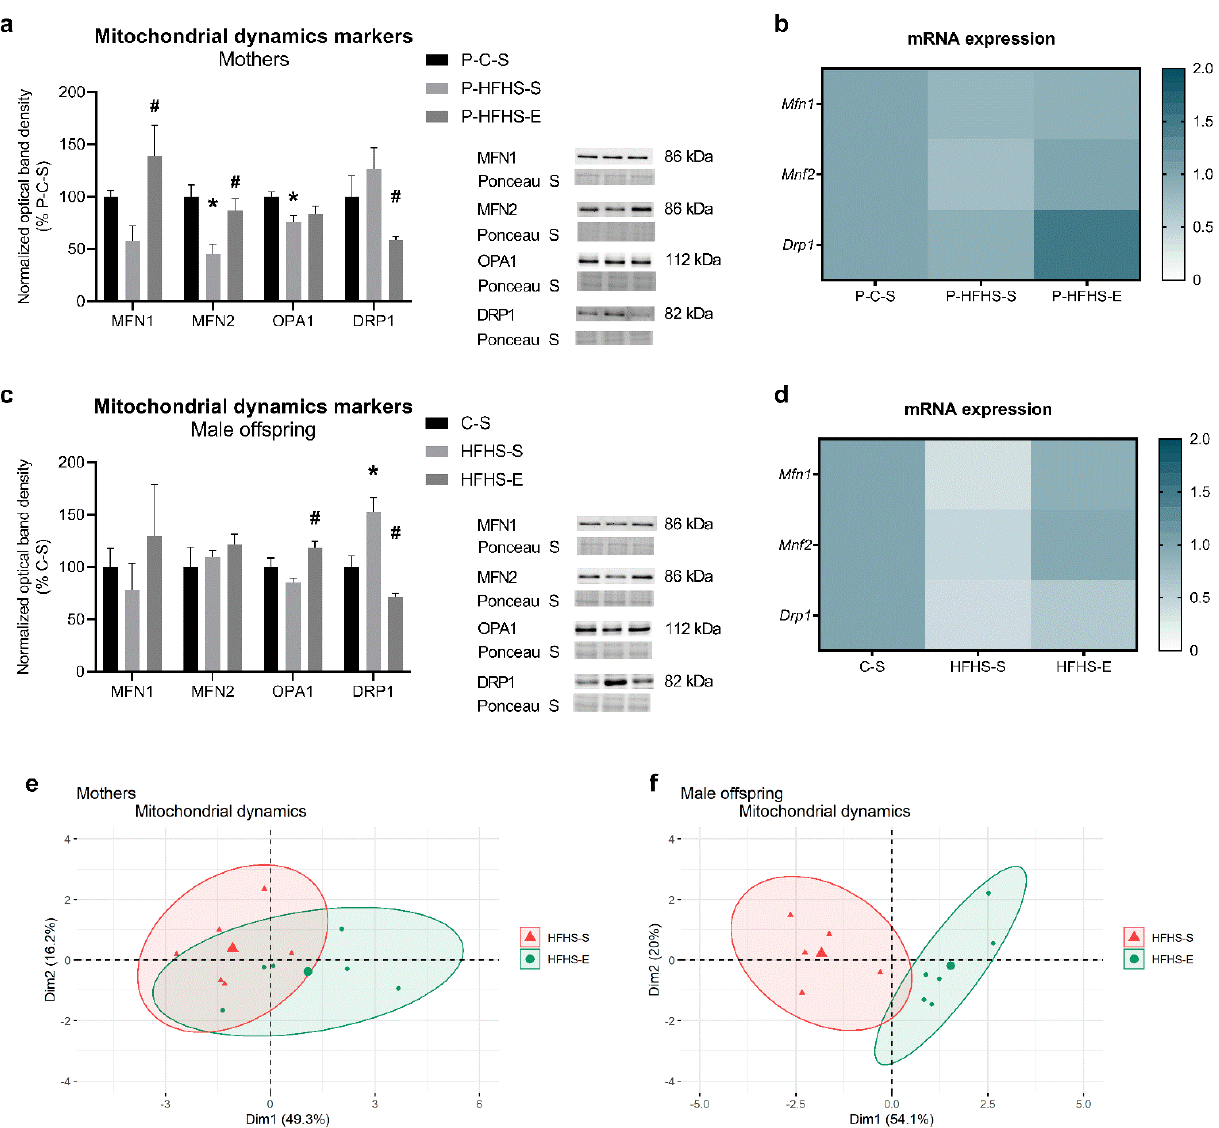
Figure 3. Effects of maternal HFHS and GE on different markers of liver mitochondrial dynamics in mothers: ( a ) relative mitochondrial content of MFN1, MFN2, OPA1, and DRP1, ( b ) heat map showing the relative transcripts for Mfn1 , Mfn2 , and Drp1 , ( c ) principal component analysis of hepatic mitochondrial dynamics markers; and in the offspring: ( d ) relative mitochondrial content of MFN1, MFN2, OPA1, and DRP1, ( e ) heat map showing the relative hepatic transcripts for Mfn1 , Mfn2 , and Drp1 , ( f ) principal component analysis of hepatic mitochondrial dynamics markers. GE—gestational exercise; C—mothers fed with control diet; HFHS—mothers fed with high-fat high-sucrose diet; S—sedentary mothers; E—exercised mothers. * vs. P-C-S ( p < 0.05) or vs. C-S ( p < 0.05) in mothers or offspring, respectively. # vs. P-HFHS-S ( p < 0.05) or vs. HFHS-S ( p < 0.05) in mothers or offspring, respectively.